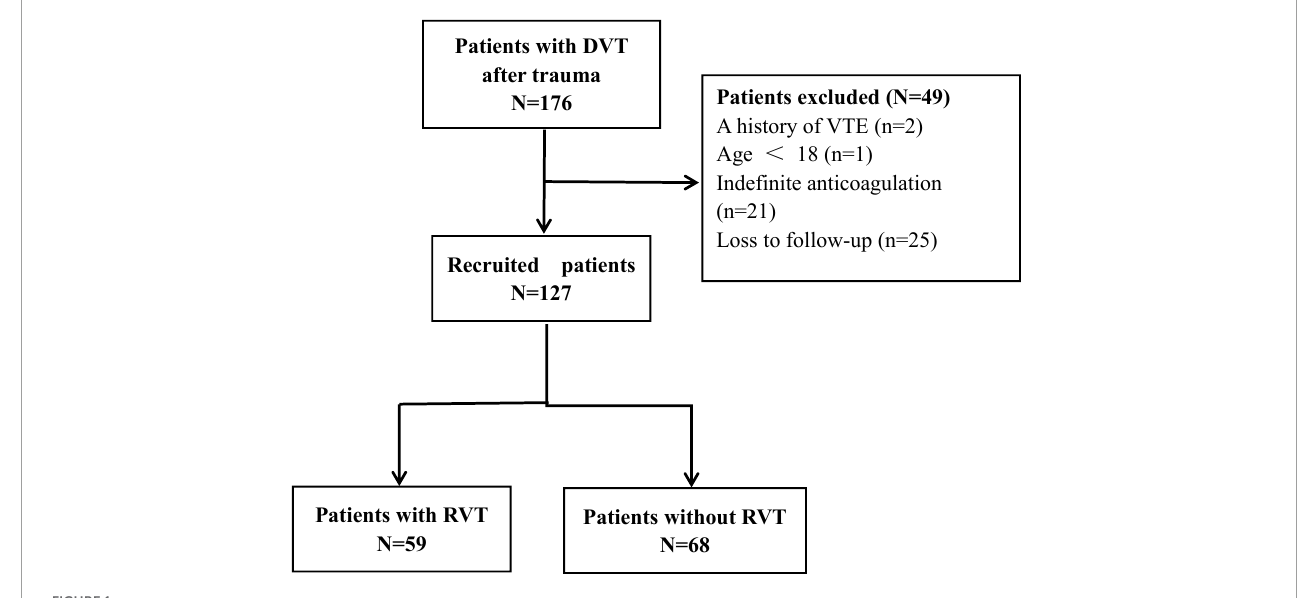
FIGURE1 Flow diagram of the study. DVT, deep vein thrombosis; VTE, venous thromboembolism; RVT, residual venous thrombosis.